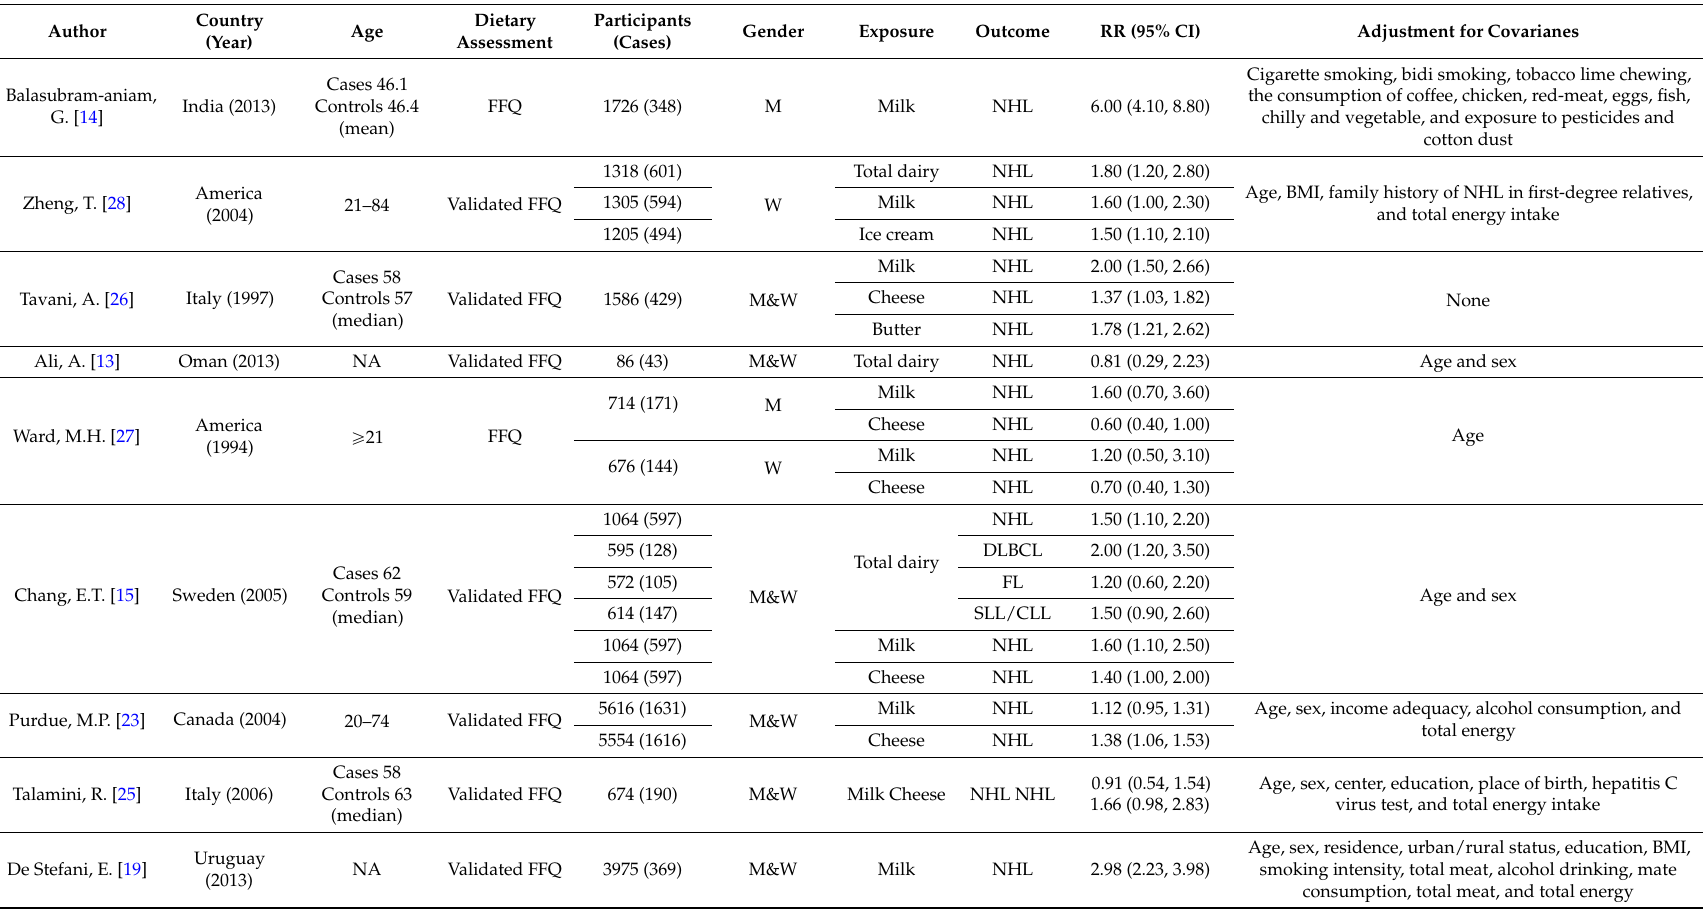
Table 1. Characteristics of case-control studies on dairy product consumption and the risk of